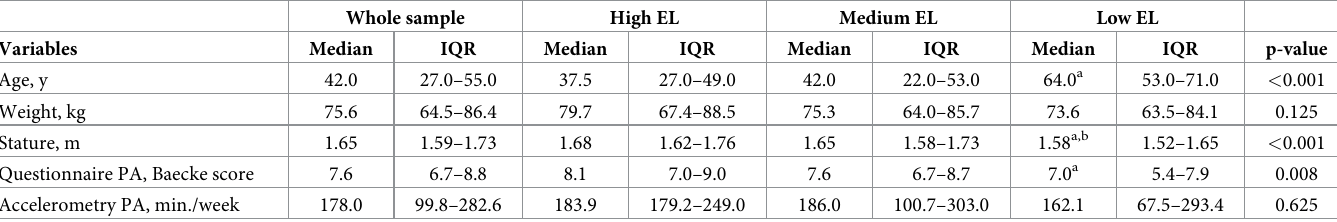
Table 1. Sample characteristics (n = 251).